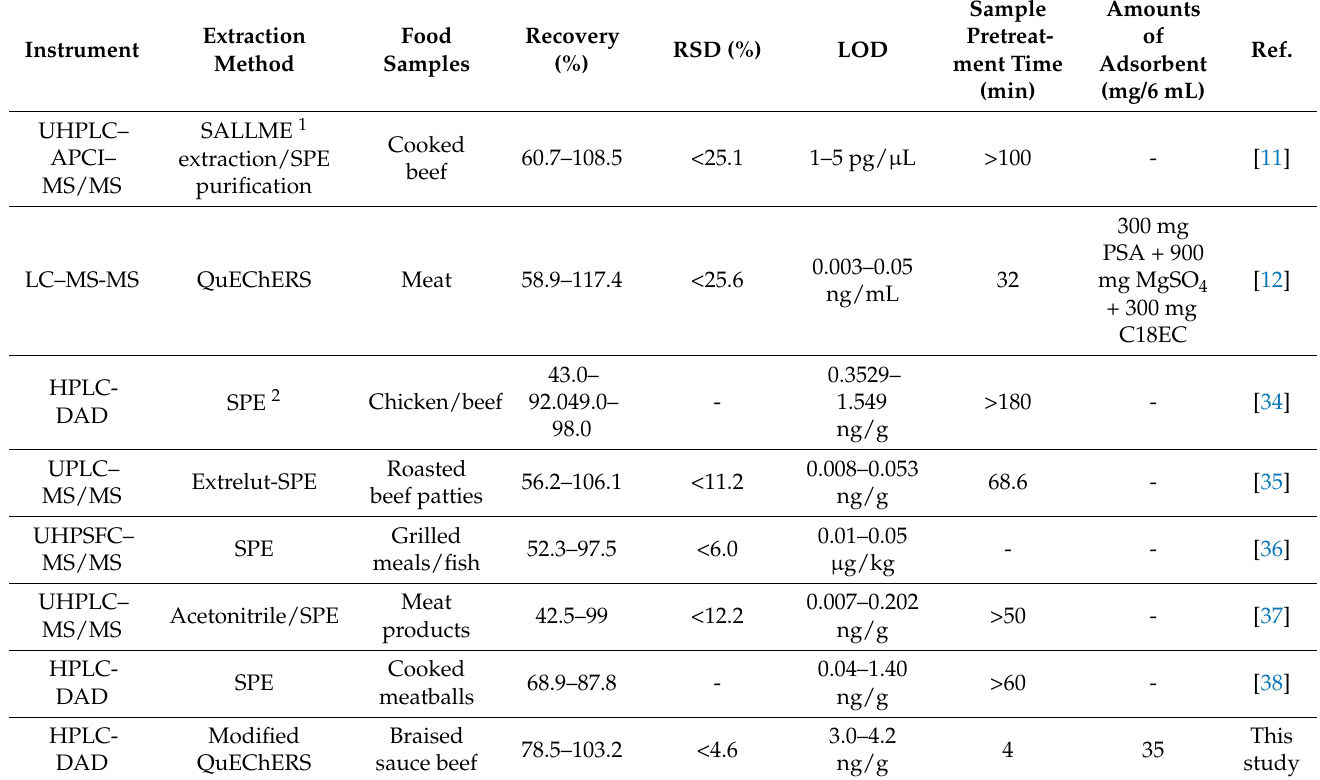
Table 2. Comparison of the present method with other